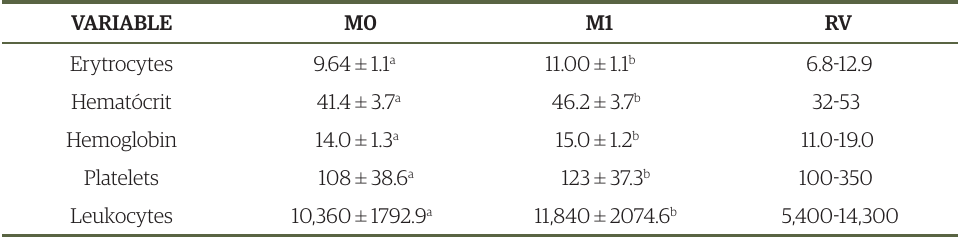
table 2. Mean and standard deviations of erythrocytes (mm 3 ), hematocrit (%), hemoglobin (g dL -1 ), platelets (10 3 μ L -1 ) and leukocytes (mm 3 ) of Mangalarga Marchador Horses before (M0) and after (M1) marcha exercise, followed by their respective reference values